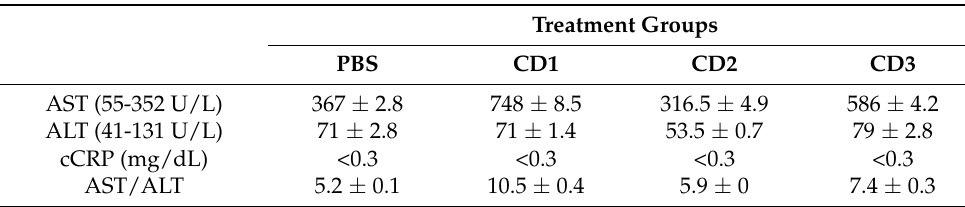
Table 2. The results of serum samples collected from following the intravenous administration of different polymers to healthy mice (n = 5, AVG ±